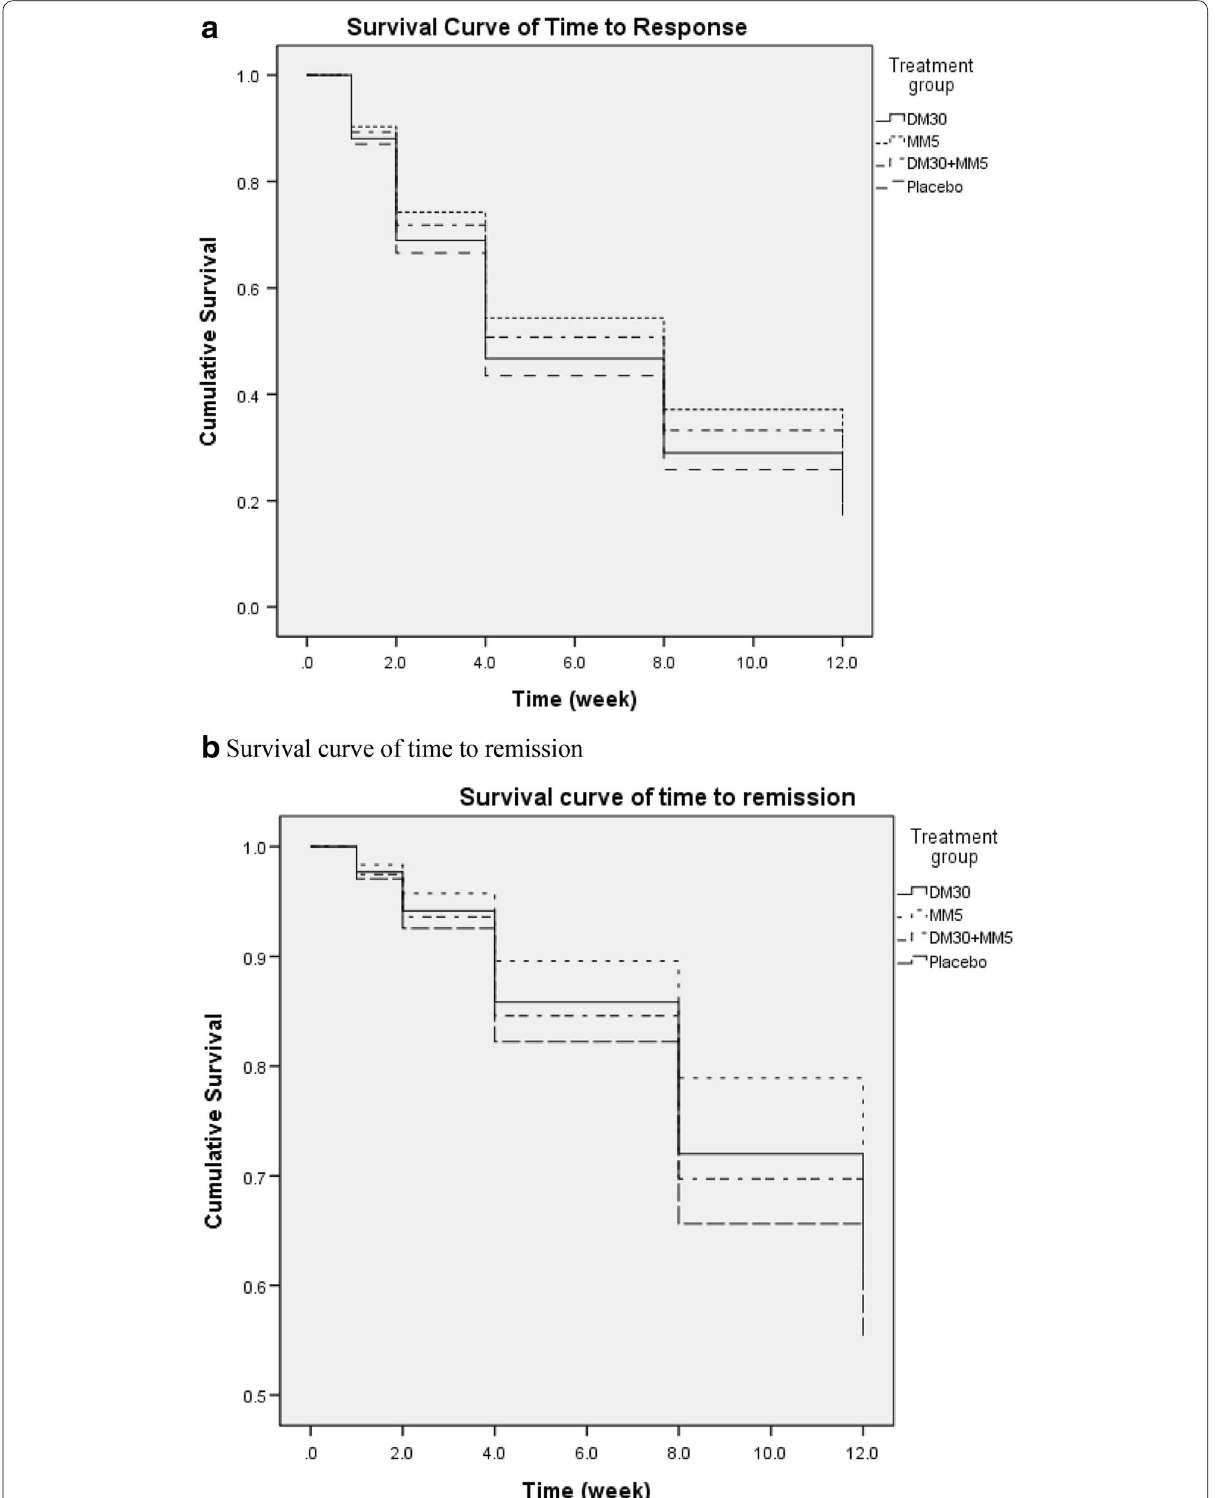
Fig. 3 a Survival curve of time to response in BD‑II patients taking add‑on DM30, MM5, and DM30 to response in BD‑II patients taking add‑on DM30, MM5, and DM30